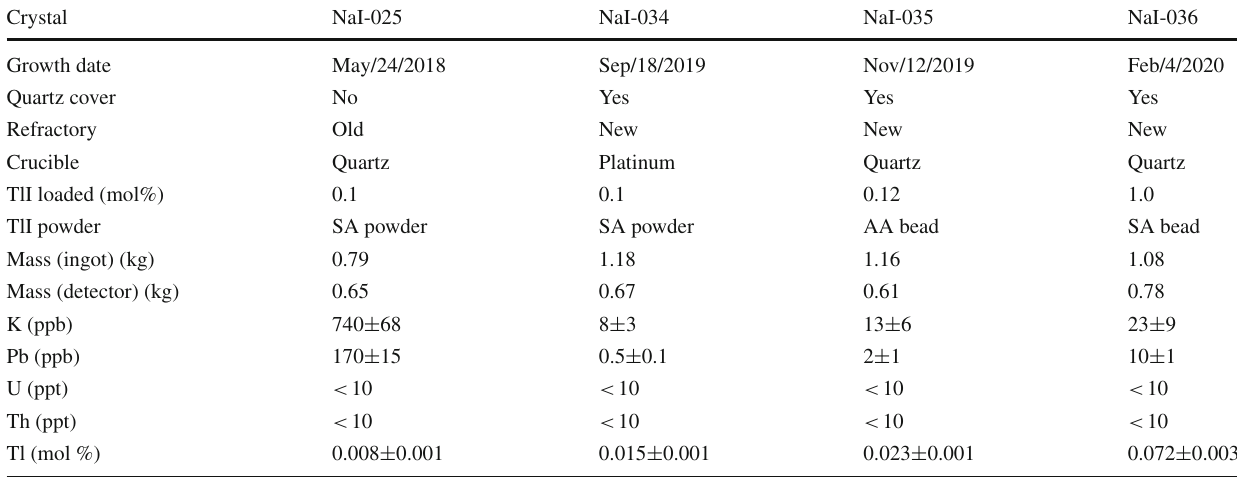
Table 2 The top six entries list growth conditions of each crystal ingot, where SA and AA indicate Sigma-Aldrich and Alpha-Aesar, respec- tively. The middle two entries list the masses of the crystal ingots and